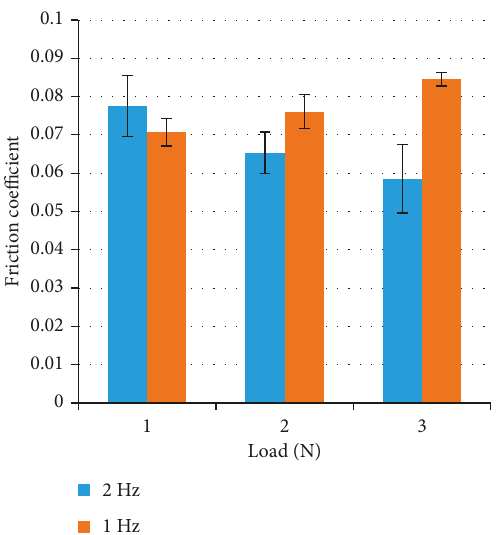
Figure 4: Effect of load under albumin solution lubrication.